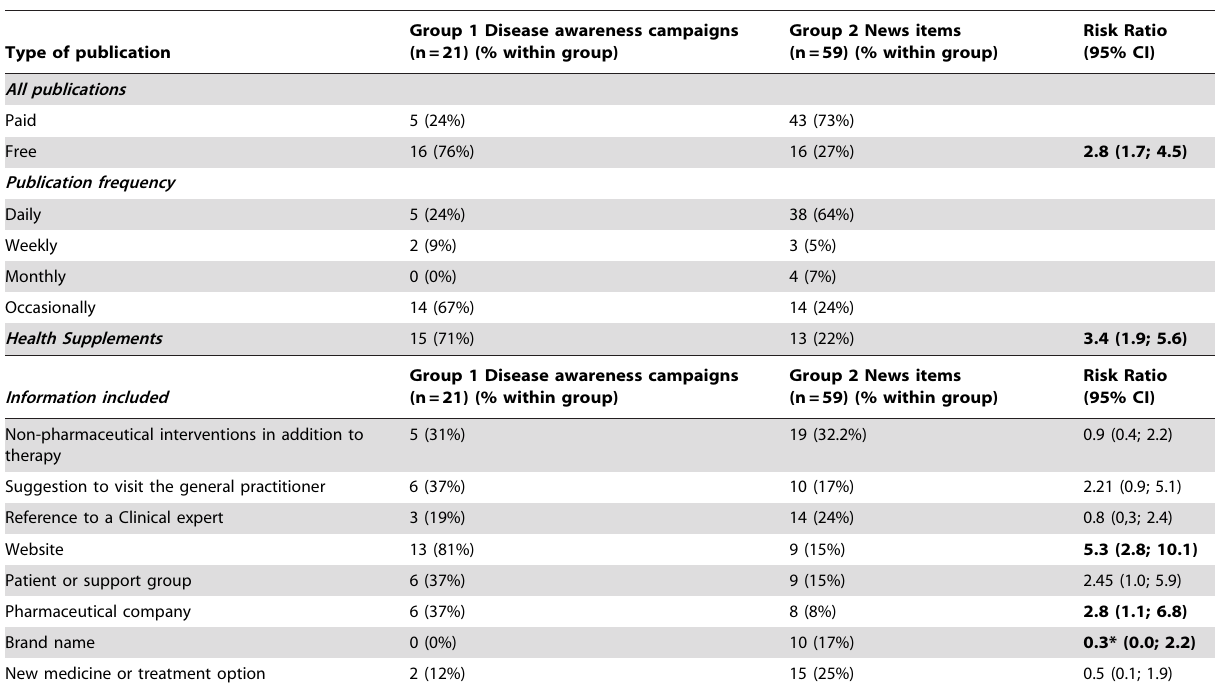
Table 2. Material